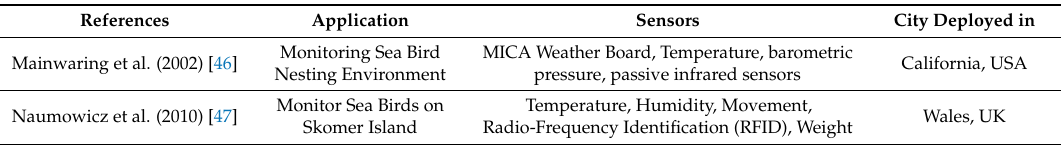
Table 5. Examples of prototyped applications for habitat monitoring.